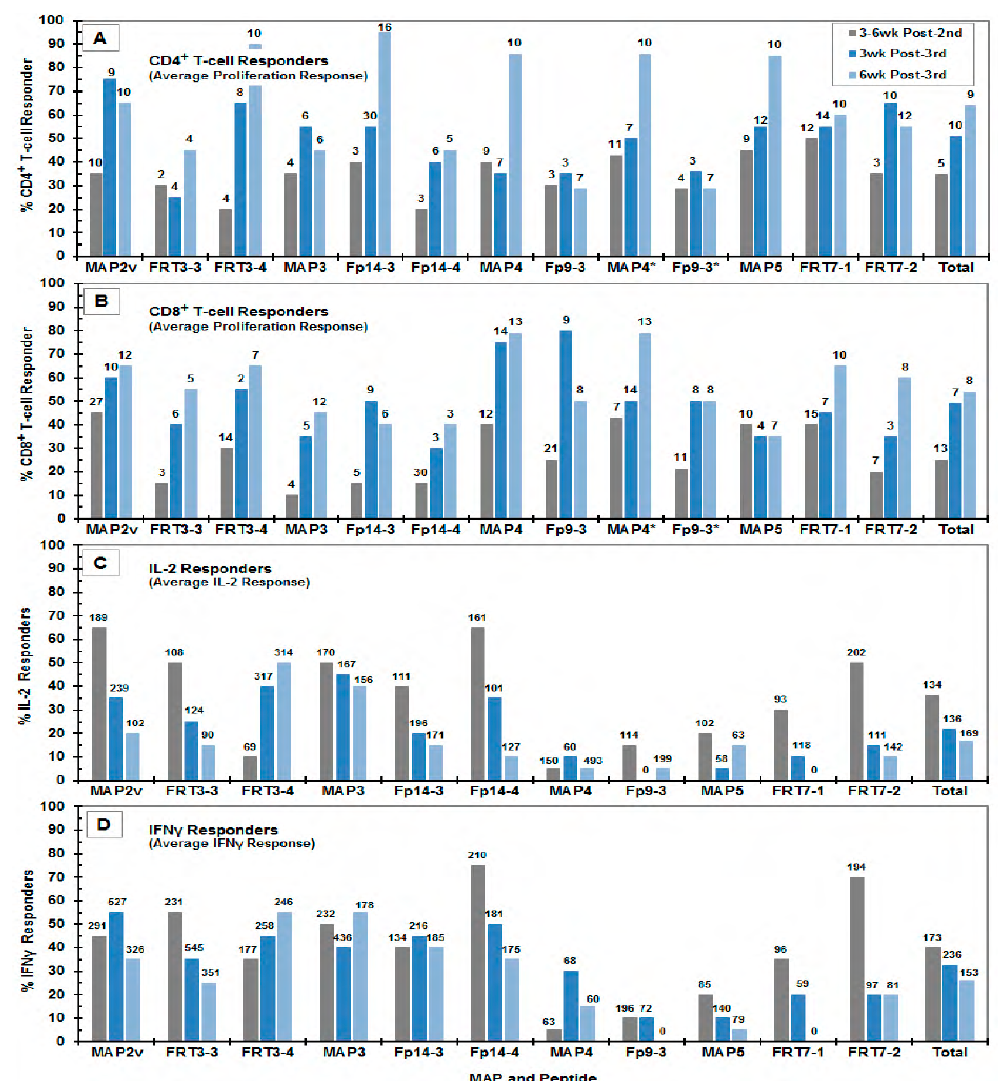
Figure 4. Average percent responder rates and average magnitudes of CD4 + and CD8 + T-cell proliferation and the cytokine production at the three time points tested. The average percent responder rates of the CD4 + ( A ) and CD8 + ( B ) T-cell proliferation and the IL-2 ( C ) and IFN γ ( D ) production of the PBMC from the MAP-vaccinated cats are shown in response to in vitro stimulation with MAP or FIV peptide. The three time points tested are 3-6 weeks post-second vaccination (grey bars), three weeks post-third vaccination (dark blue bars), and three weeks post-third vaccination (blue bars), as shown in the insert of panel A. The average magnitude of response are shown above each bar. The three bars in the last column above “Total” represents the total or overall average of each time point with the overall average magnitude above each bar. Note that the CD4 + and CD8 + T-cell responder rates to MAP4 and Fp9-3 at six weeks post-third vaccination is missing the results from Group 1a.